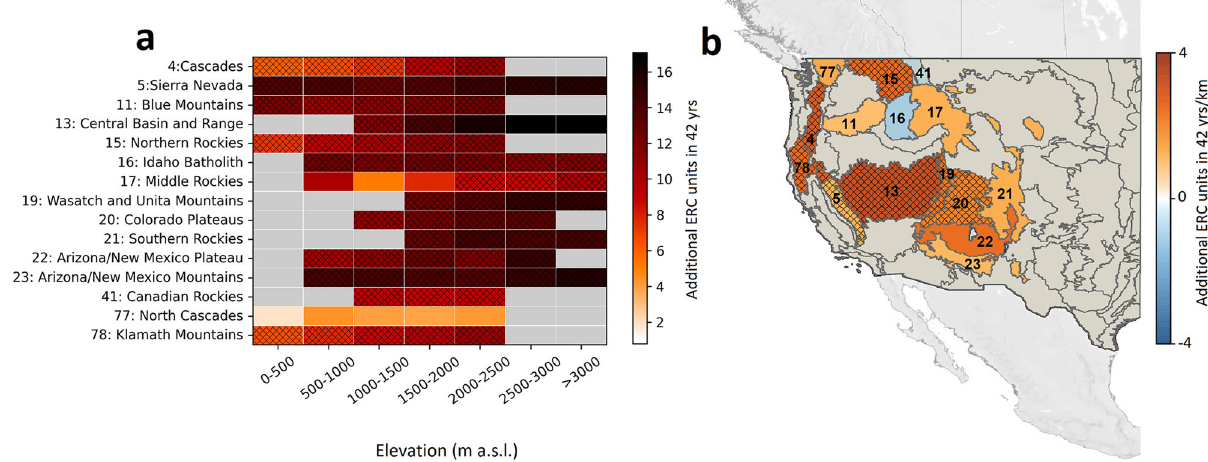
Fig.1|Elevation-dependenttrendsin fi redangeracrossmontaneecoregionsin the western US. a Temporal trends in warm-season (May – September) average energyrelease component(ERC)from1979 to2020ineachelevationbandineach mountainous ecoregion of the western US. Elevation bands with less than 250km 2 of land are removedfrom the analysis and are shown with grayshading. b Slopeof ERCtemporaltrendsacrosselevationbands,wherepositivevaluesindicatealarger